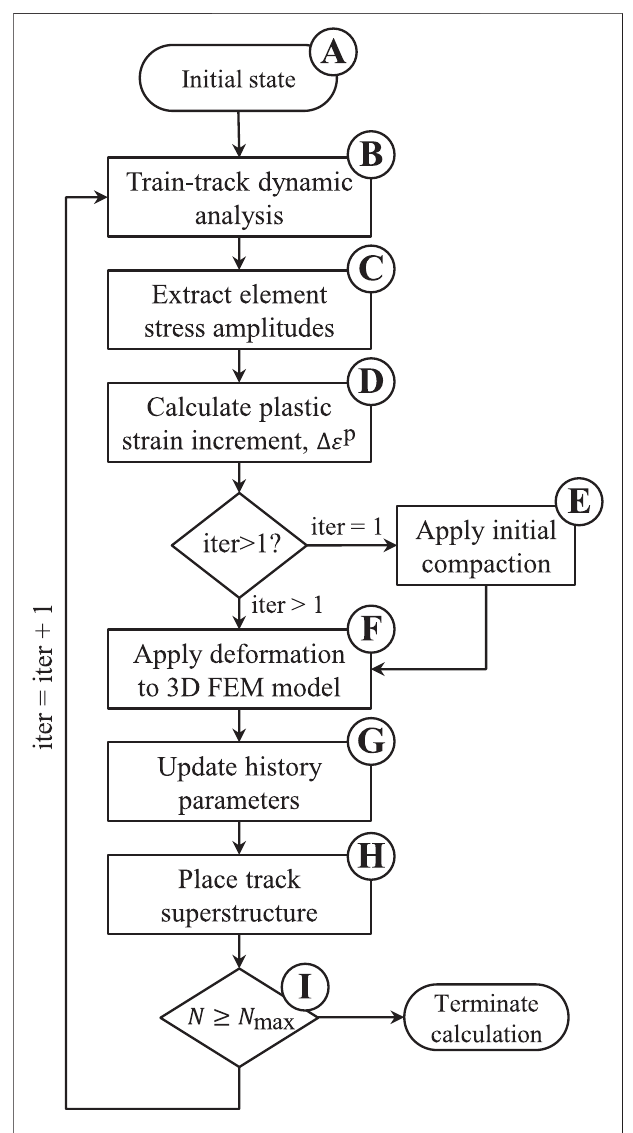
FIGURE4| Mainstepsimplementedin Pegasus forthecalculationofthe track settlements. Each complete iteration ( iter ) is separated in six or seven steps (Varandas et al.,